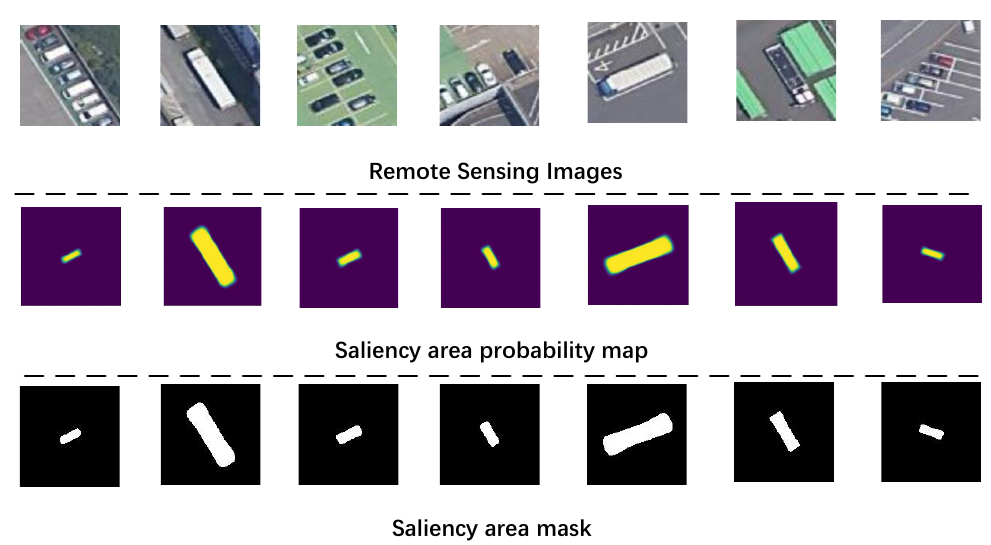
Figure 7. The figure shows the visualization of the output probability map of the saliency region detection stage and the visualization of the saliency region generated from the probability